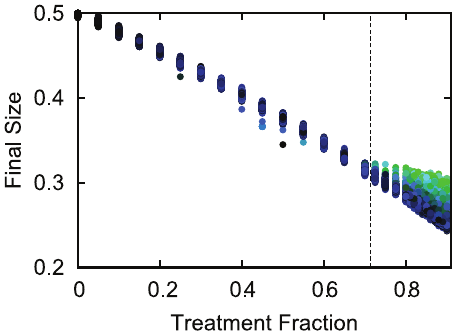
Figure 10. Monte Carlo simulations on a network with heterogeneous contact structure. ( c ~ 0 : 002 ). Every point repre- sents one of over 10,000 simulations on networks of size 250 000, with color indicating the proportion of resistance in the FS (from black, 100% wild-type, to green, 100% resistant). r (cid:3) (Eq. (14)) is shown in dashed black line. The effectiveness of r (cid:3) is robust to stochasticity and heterogeneous contact structures. Other parameters: